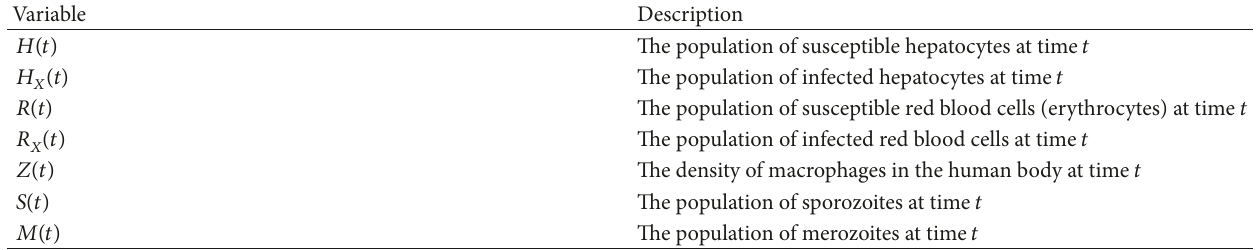
Table 1: Symbols and definition of state variables considered in the model.